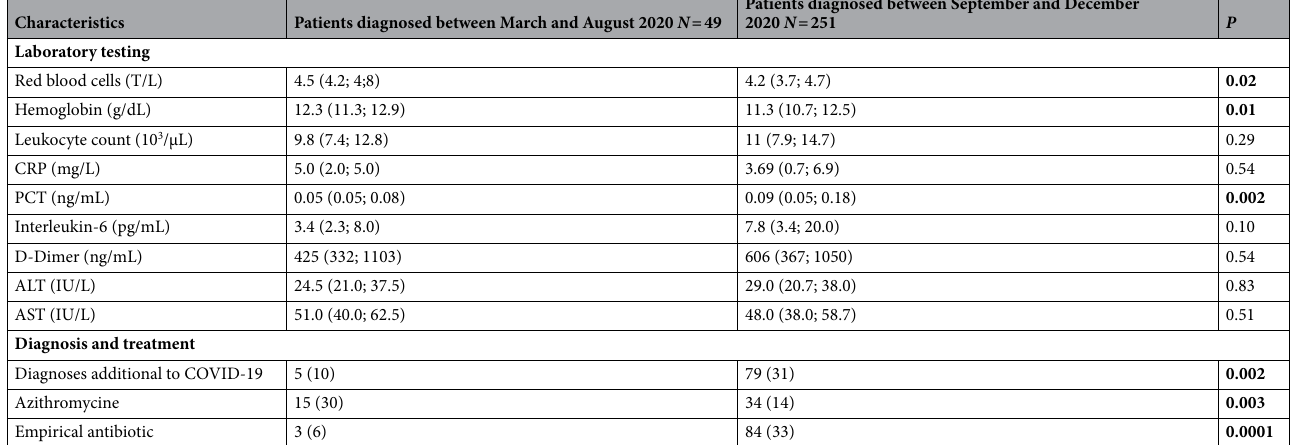
Table 4. Diagnostics and treatment of infants with COVID-19 during the 1st and 2nd waves of the pandemic. Data are presented as Median (IQR) or n (%), as appropriate. ALT—alanine aminotransferase;